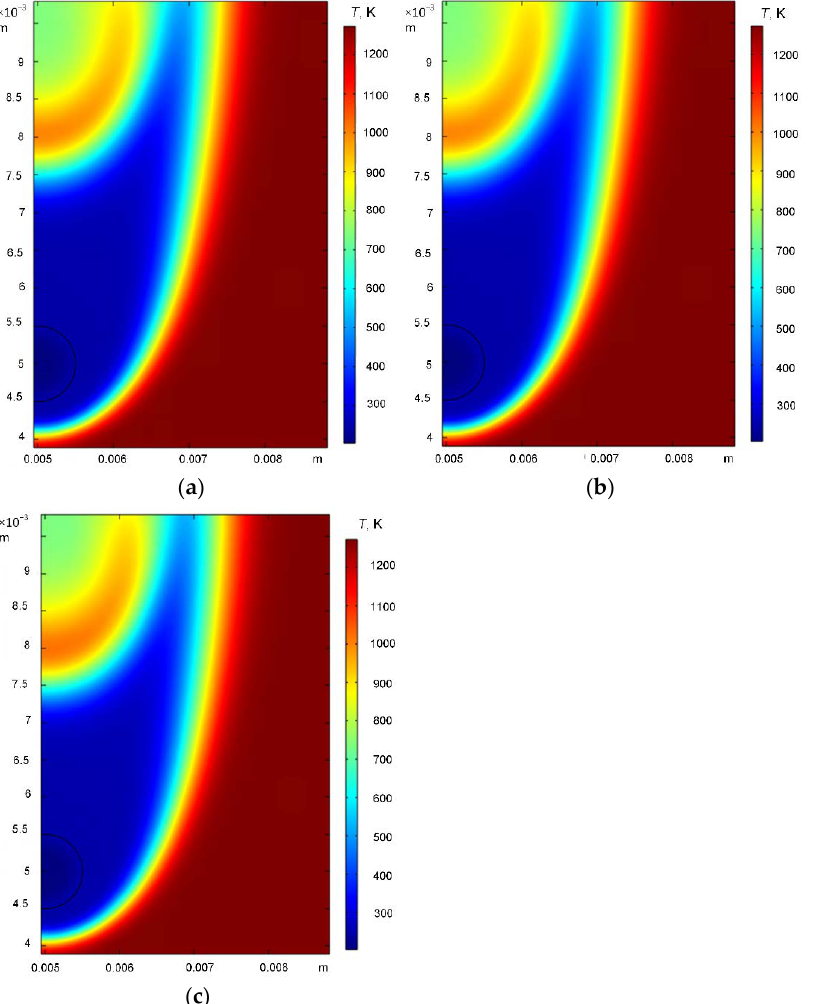
Figure 6. The temperature fields of the gas hydrate ignition area under the conditions of convective heating when varying the mass dissociation rate of the gas hydrate at a heating source temperature of 1273 K and R g = 0.5 mm: ( a ) w d = 0.005 kg/(m 2 ·s), ( b ) w d = 0.01 kg/(m 2 ·s), ( c ) w d = 0.1 kg/(m 2 ·s). The ice in the gas hydrate composition melts to produce water. Liquid evaporation has a decisive effect on the characteristics of gas hydrate ignition and combustion at rel- atively low temperatures [1]. The water vapors were found [1] to significantly change the development of some elementary reactions (chemical effect), which led to a lower flame temperature. The vapor resulting from the water evaporation also reduces the combus- tion rate [1]. The evaporation rate of water generated on the gas hydrate surface is un- stable as it is conditioned by dissociation, which, in turn, occurs at different rates de- pending on the different factors and conditions described above. The water evaporation rate affects the release of gas from the hydrate pores and the self-preservation phenom- enon that suppresses the gas release. The more slowly the water evaporates from the surface, the higher the risk of the formation of an ice crust under certain conditions. The ice crust clogs the channels emerging from the pores for combustible gas release. There- fore, the rate of water evaporation from the gas hydrate surface is the key factor in the kinetics of hydrate combustion that should be taken into account and analyzed. Figure 7a–c presents the gas hydrate ignition delay times when varying the mass evaporation rate of water and the heating source temperature using radiant, convective, and conduc- tive heating schemes. It is clear from Figure 7 that the ignition delay times changed steadily with the growth in the mass rate of water evaporation from the hydrate particle surface. At a heating source temperature of 1273 К, the ignition delay times for all of the heating schemes (radiant, convective, and conductive) increased by 63%, 23%, and 4%, respectively, with an increase in the mass evaporation rate of water from 0.005 kg/m 2 ·s to 0.05 kg/m 2 ·s. At T = 1273 K, a rise in the mass evaporation rate to 0.1 kg/m 2 ·s increased the ignition delay times by 15%, on average, when convective and conductive heating were applied (Figure 7b, с). Under the conditions of radiant heating, at the same heating source temperature and evaporation rate, the ignition delay times increased almost three-fold (Figure 7a). Under the conditions of conductive heating, the ignition delay times in- creased with a rise in the mass evaporation rate of water by 10–80% (Figure 7 с ). Such changes in the ignition delay times can be explained by the following. When the dissoci- ation rate reaches its peak, the ice on the gas hydrate particle surface quickly melts and water evaporation becomes more rapid. With an increase in the heating source temper- ature, the water film on the particle surface builds up and becomes thicker, thus pre- venting the release of gas from the hydrate. When gas passes through a thick water film,